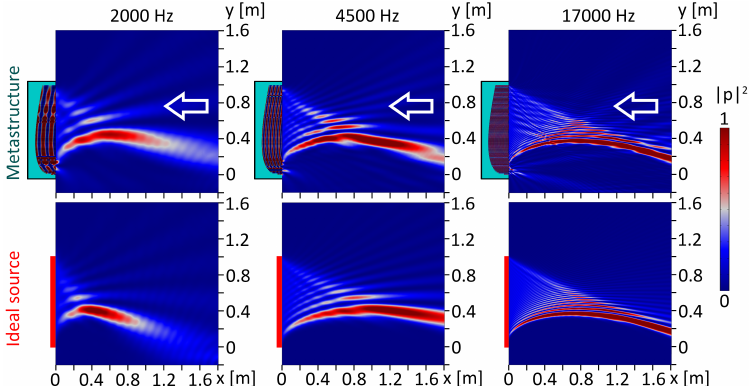
Figure 4. Simulated bending fields. ( Top panels) bending beams generated by the metastructure at the frequencies: 2000, 4500 and 17,000 Hz; ( Bottom panels) bending beams generated by an ideal source for comparison. White arrows indicate the incident plane